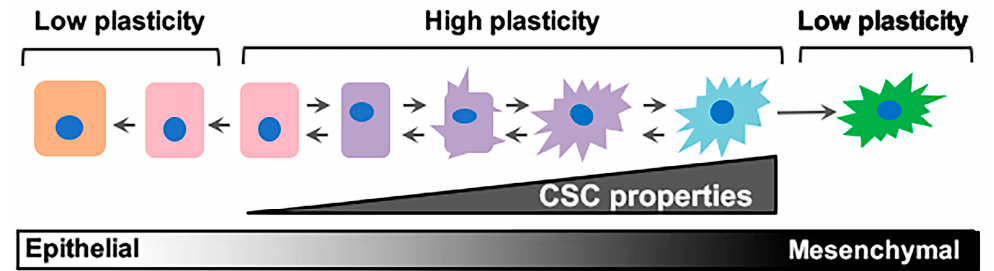
Figure 1. Epithelial/non-stem cell to mesenchymal/cancer stem cell plasticity. Epithelial/non-cancer stem cells retaining cell plasticity respond to environmental or intrinsic cues by fluidly transitioning through intermediary stages until reaching a mesenchymal/cancer stem cell state. These intermediary states hold immense plasticity and are the roots behind metastatic dissemination and therapeutic failure. CSC: cancer stem cell.